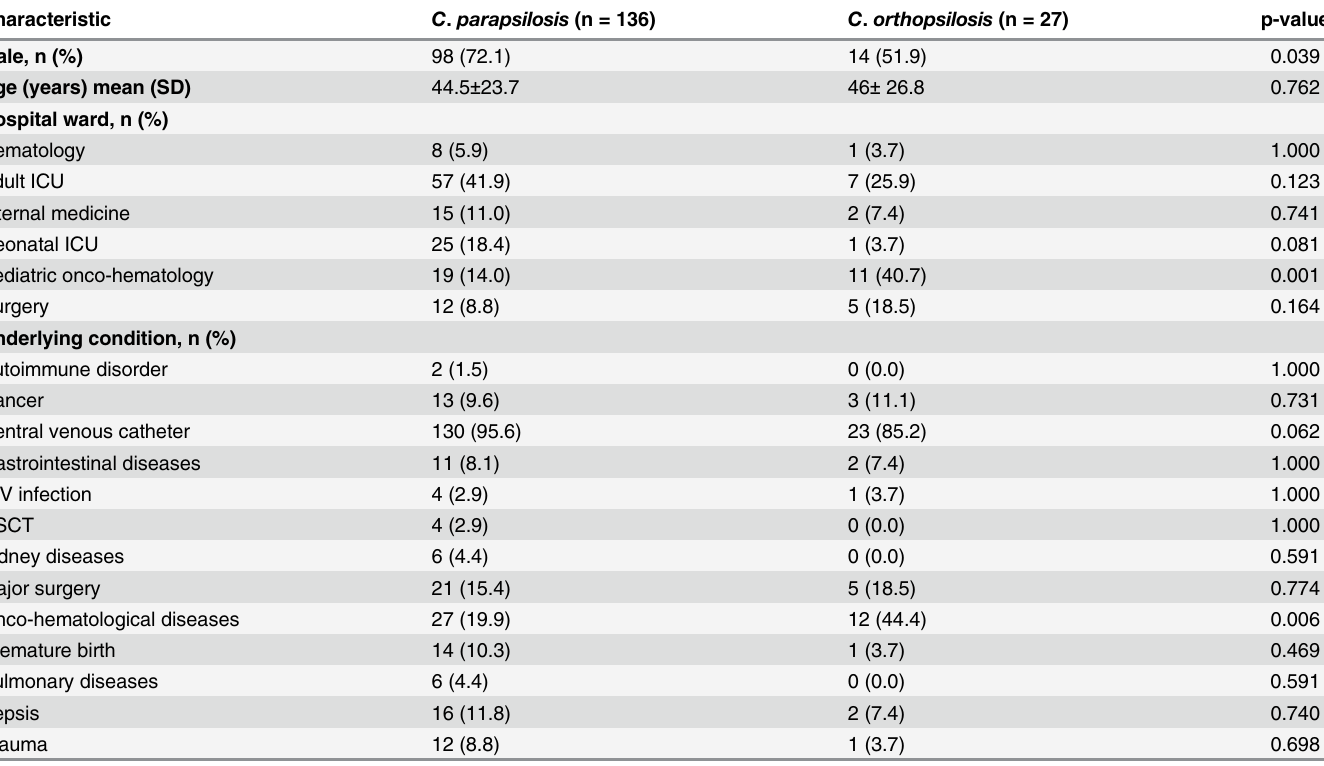
Table 1. Characteristics of 163 patients with Candida parapsilosis complex